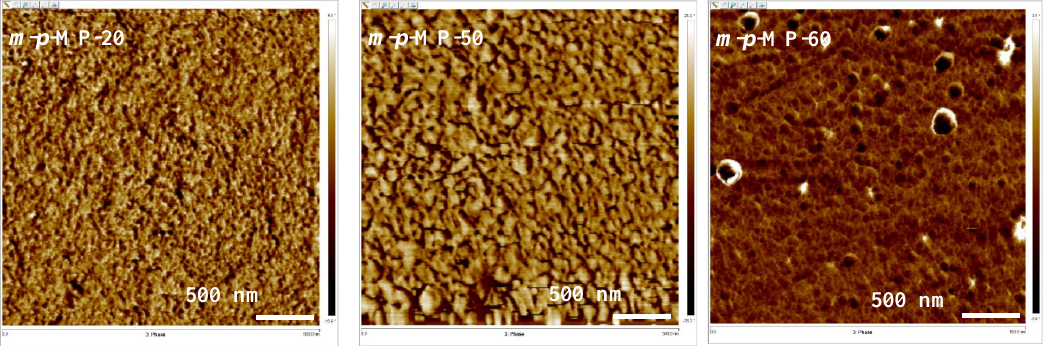
Figure 4. Atomic force microscopy (AFM) phase images of the m-p -MP-20, m-p -MP-50, and m-p -MP-60 copolymer membranes.